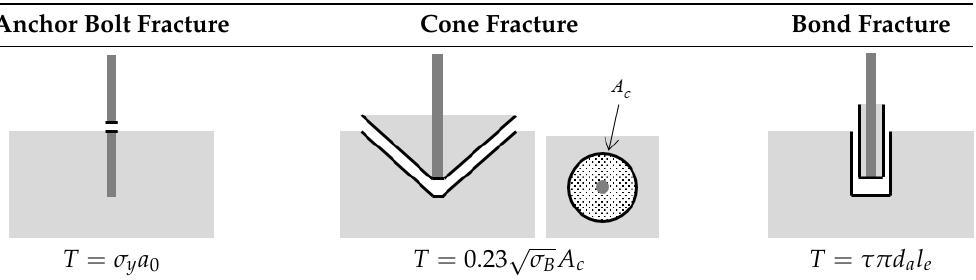
Table 1. Typical fracture patterns of anchor bolts and corresponding strength.